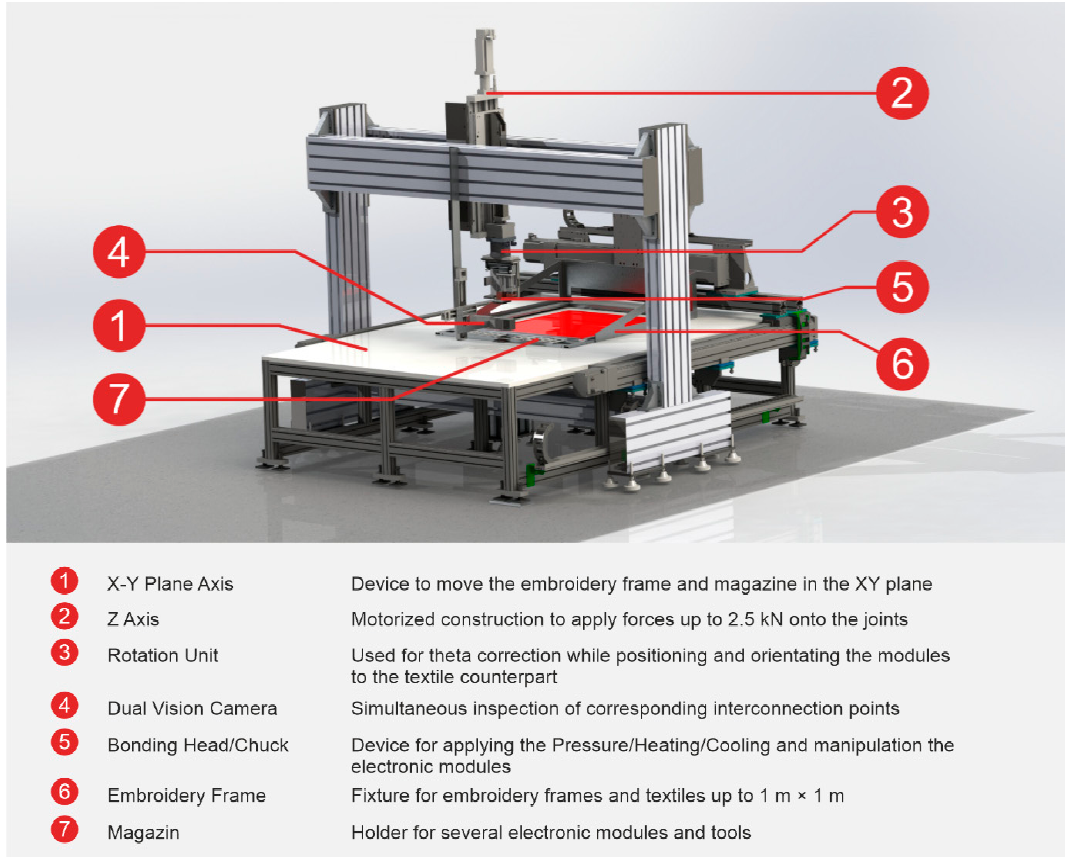
Figure 4. Overview of relevant parts of the E-Textile